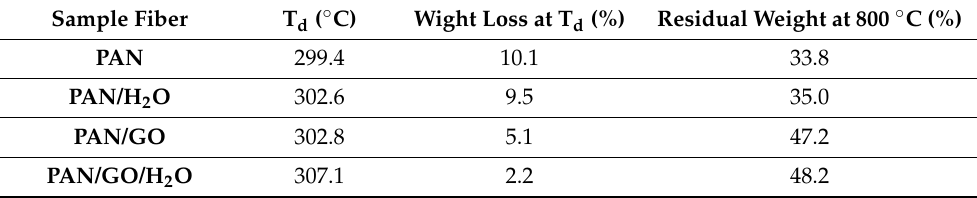
Algorithm description, Table S1: Molar absorption constant at 16 °C and Table S2: Chemical structure and calculated solubility parameter. Table S3: An overview on the properties of the PAN fibers prepared in our work and previous